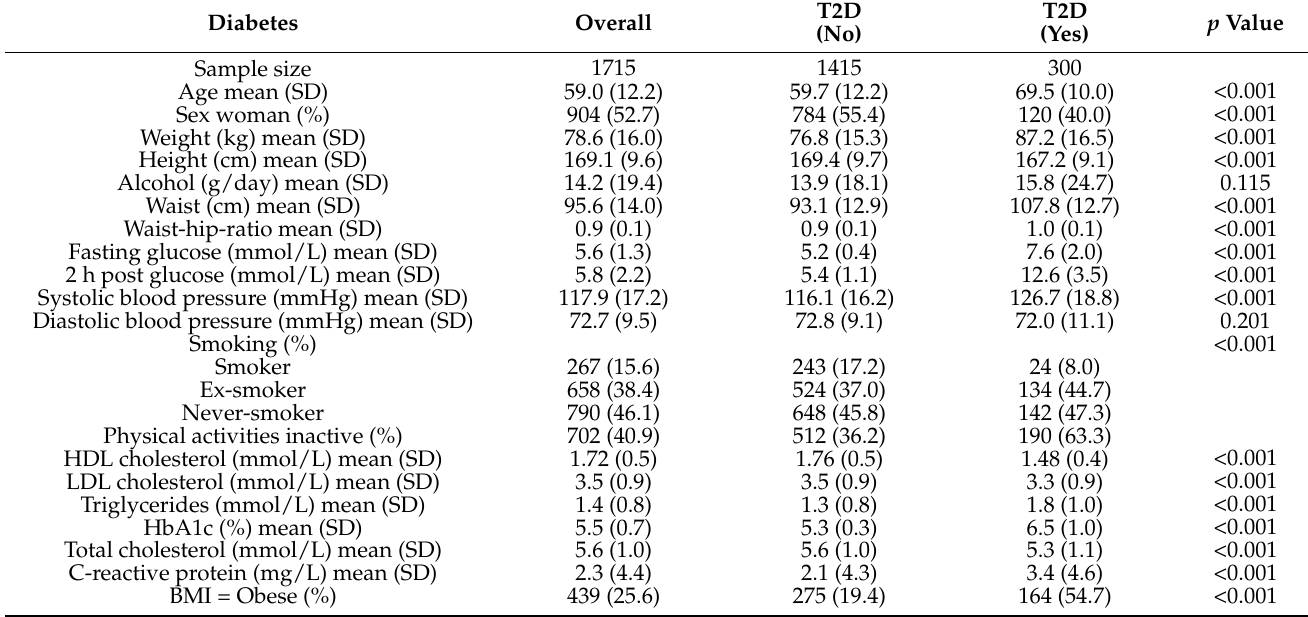
Table 2. Characteristics of the KORA FF4 participants based on their diabetic status. Mean and standard deviation is provided for quantitative variables. Count and percentage are provided for categorical variables. The significant difference of population characteristics between the diabetic patients and nondiabetic participants was tested, respectively. Categorical variables were calculated via chi square test. Student’s t test was used for continuous